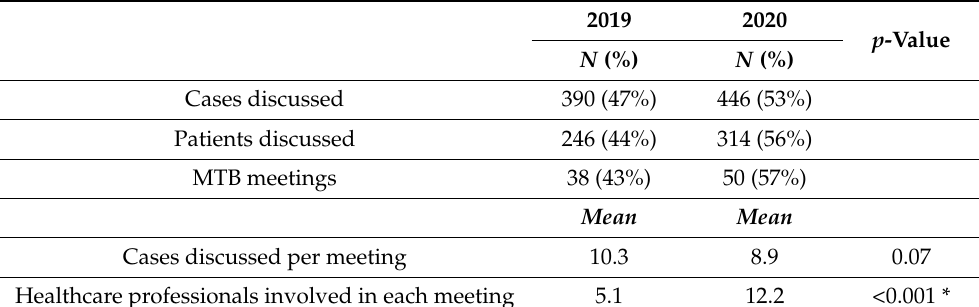
Table 3. RC-MTB activity volumes and organizational